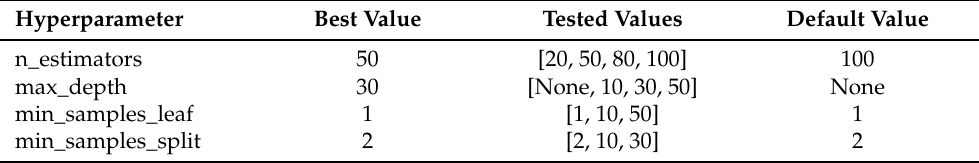
Table 1. Best set of hyperparameters and its tested values used for grid search. n_estimators is the number of trees in the forest. max_depth is the maximum depth of the tree. min_samples_leaf is the minimum number of samples required to be at a leaf node. min_samples_split is the minimum number of samples required to split an internal node. If max_depth is None, then nodes are expanded until all leaves are pure or until all leaves contain less than min_samples_split